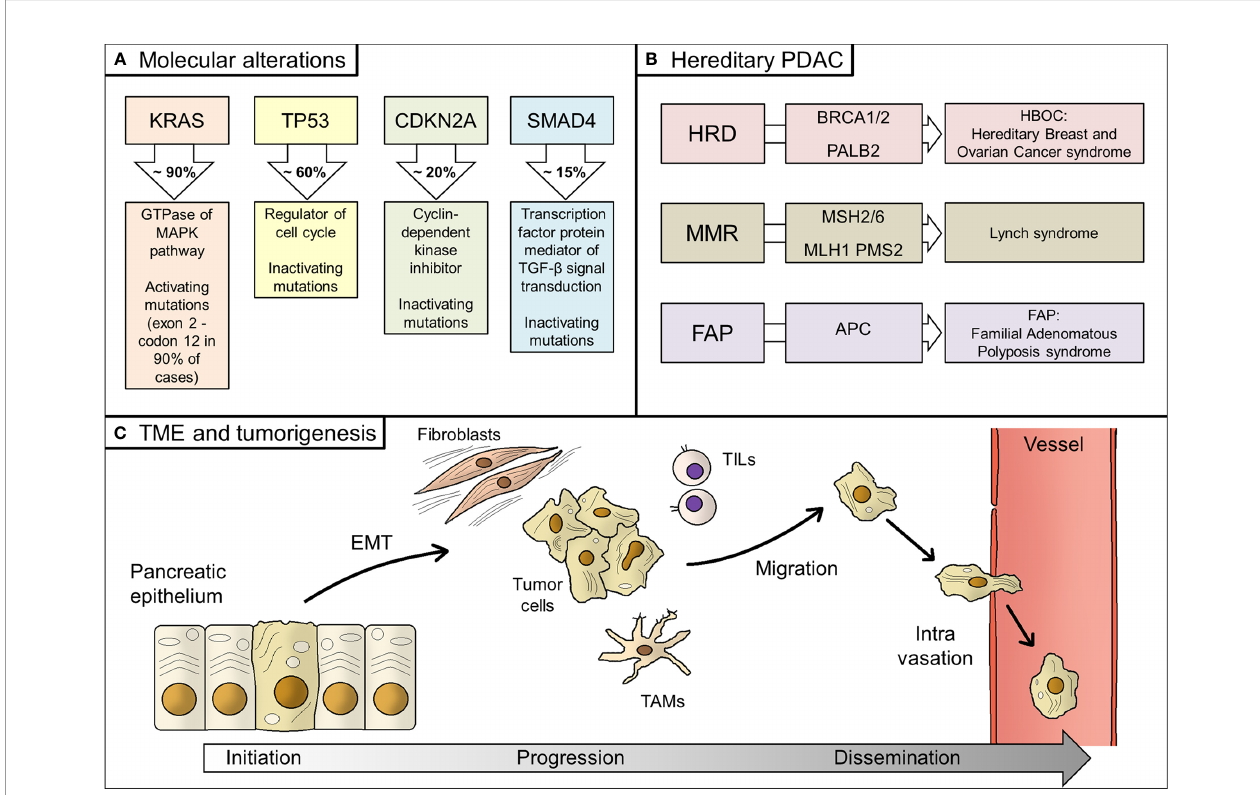
FIGURE 1 | Biology of PDAC. (A) Main molecular alterations in PDAC; (B) Hereditary alterations, involved genes, and their relative syndromes; (C) Main steps of PDAC tumorigenesis, from tumor initiation to tumor progression and, fi nally, systemic dissemination. PDAC, pancreatic ductal adenocarcinoma; HRD, homologous recombination de fi ciency; TME, tumor microenvironment; EMT, epithelial-to-mesenchymal transition; TAMs, tumor-associated macrophages; TILs, tumor in fi ltrating lymphocytes; MMR, mismatch